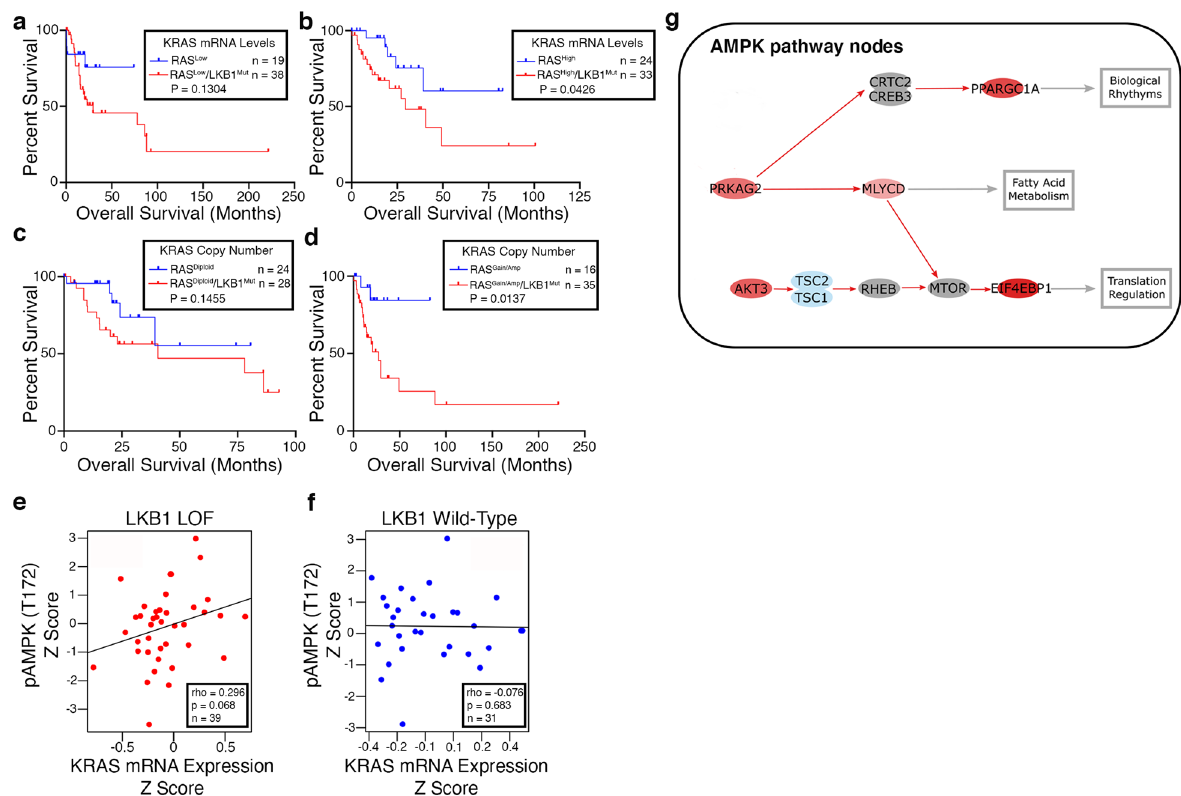
Fig. 6 High levels of oncogenic KRAS drive decreased patient survival and is associated with AMPK activation in LKB1 mutant patients. a , b Analysis of patient survival using the TCGA Pan Lung Cancer study. Kaplan – Meier plots strati fi ed by KRAS Low ( a ) or KRAS High ( b ) using oncogenic (codon 12) KRAS mRNA expression and further strati fi ed based on LKB1 deletion and loss-of-function mutation status. c , d Analysis of patient survival using the TCGA Pan Lung Cancer study. Kaplan – Meier plots strati fi ed by KRAS Low or KRAS High using oncogenic (codon 12) KRAS copy number data and further strati fi ed based on LKB1 deletion and loss-of-function mutation status. e , f Analysis of phosphorylated AMPK (T172) expression as it correlates with KRAS mRNA expression and LKB1 mutation status. g Canonical circuit activity analysis was used to estimate the activity of AMPK signaling pathway (hsa04152) that result in functional cell activities. Red color represents signi fi cantly ( p < 0.05) upregulated genes (or paths) in KRAS High /LKB1 Mut lung adenocarcinoma patients with respect to KRAS High patients, and blue represents downregulated genes (or paths). The activity of three effector circuits is signi fi cantly (FDR < 0.05) upregulated in KRAS High /LKB1 Mut patients, one ending in the node that contains the protein PPARGC1A ( p = 0.005; FDR = 0.037; Uniprot function Biological rhythms/Mitochondrial biogenesis), the second one ending in the node with the MLYCD protein ( p = 0.0064; FDR = 0.045; Uniprot function Fatty acid metabolism), and the third ending in the node containing EIF4EBP1 ( p = 0.001; FDR = 0.013; Uniprot function Translation